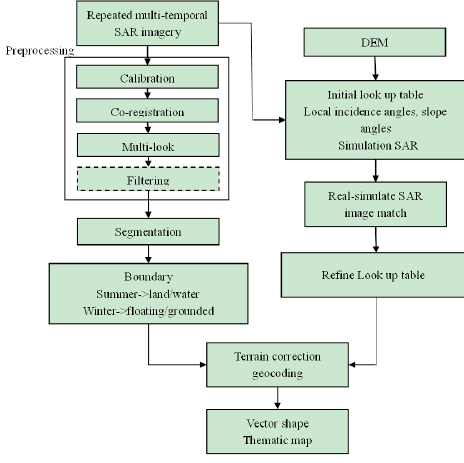
Figure 2. The flowchart of processing SAR images.